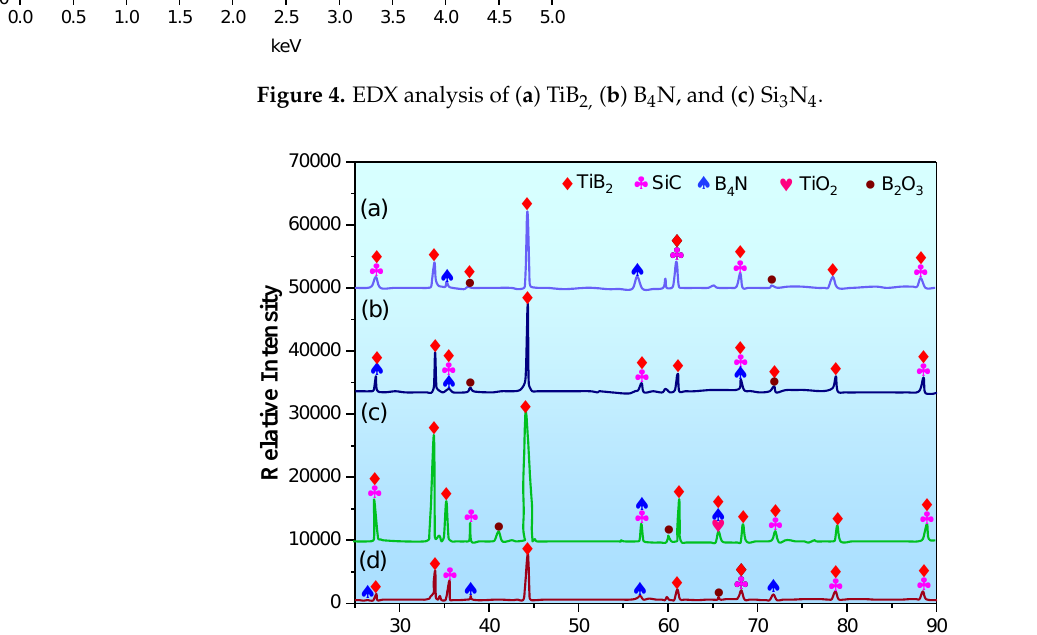
Figure 6. SEM images of the mixed powders: ( a ) TiB 2 -15Si 3 N 4 -3B 4 N, ( b ) TiB 2 -15Si 3 N 4 -6B 4 N, ( c ) TiB 2 - 30Si 3 N 4 -3B 4 N, and ( d ) TiB 2 -30Si 3 N 4 -6B 4 N. 3.2. Densification The relative density of the as-sintered specimens, as shown in Figure 7, reveals the influence of B 4 N percentage (3% to 6%) on the composite specimen’s density. For each specimen, five readings were taken, and the average is presented in Figure 7. The relative density was 98.2% in a TiB 2 -15Si 3 N 4 -3B 4 N composite, but only 97% when B 4 N is raised to 6%. TiB 2 -30Si 3 N 4 -3B 4 N and TiB 2 -30Si 3 N 4 -6B 4 N both followed the same densification pattern as the composites above, having relative densities of 99.5% and 98.8%, respectively. The density of TiB 2 -30Si 3 N 4 -6B 4 N is slightly lower than that of TiB 2 -30Si 3 N 4 - 3B 4 N, indicating that B 4 N has a negligible effect on the composite ’s den sity. The microstructural evolution also revealed that the sintering factors (1850 °C/50 MPa/10 min),